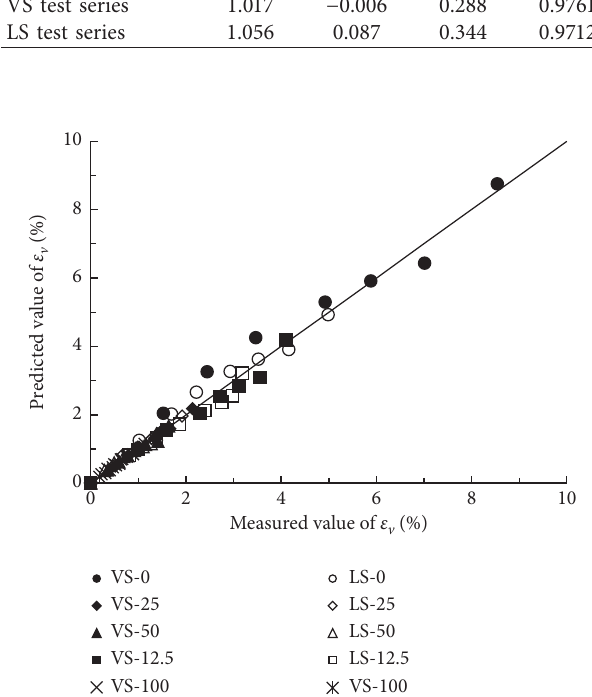
Figure 9: Comparison between the predicted VSS using (2) and the measured VSS from laboratory Table 4 indicated that the internal friction angle of saturated specimen increased with the surcharge because of the increased dry unit weight. In Table 4, K